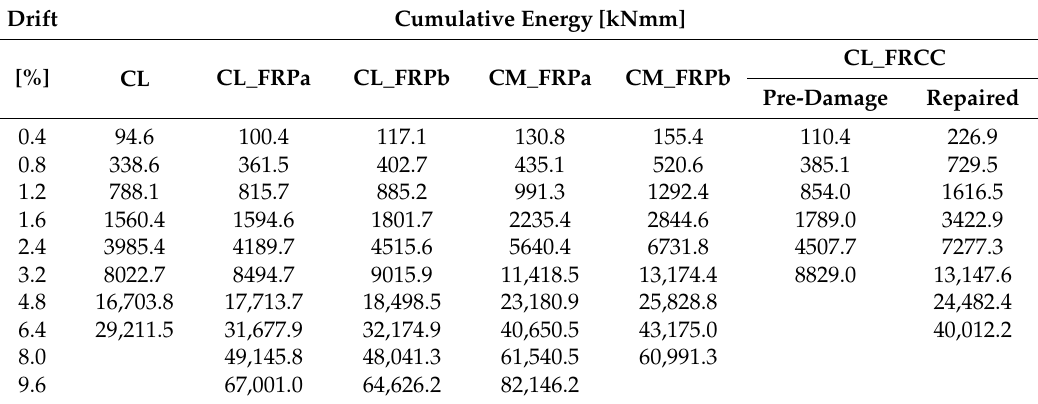
Table 4. Cumulative energy